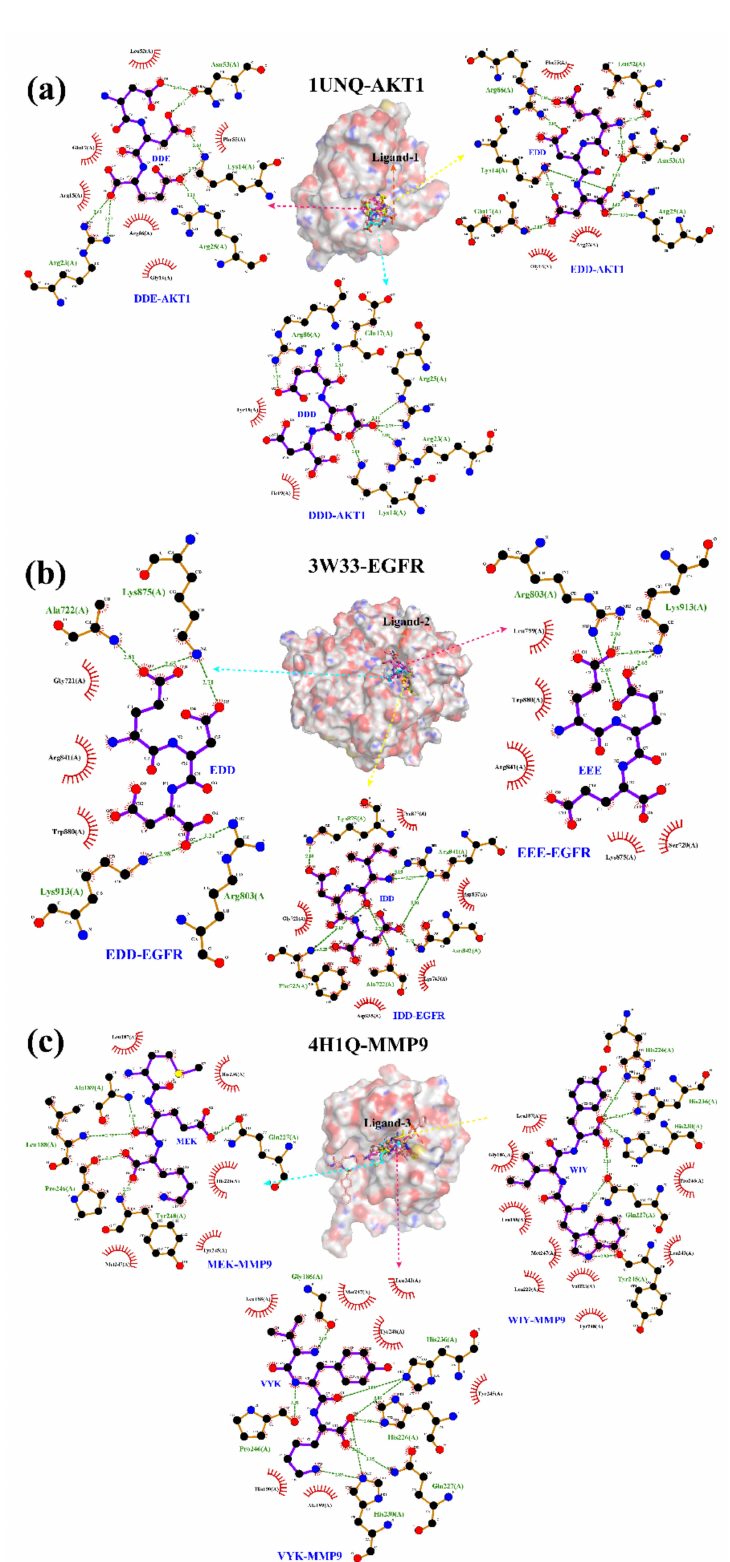
Figure 5. Tripeptides docked into the binding site of the selected target (AKT1 ( a ), EGFR ( b ), and MMP9 ( c )) crystal structures using the Ligplot software (Ver. 2.2). The peptides are presented as a purple stick model. Hydrogen bonds are indicated by dashed lines between the atoms involved, while an arc represents hydrophobic contacts with spokes radiating towards the ligand atoms they